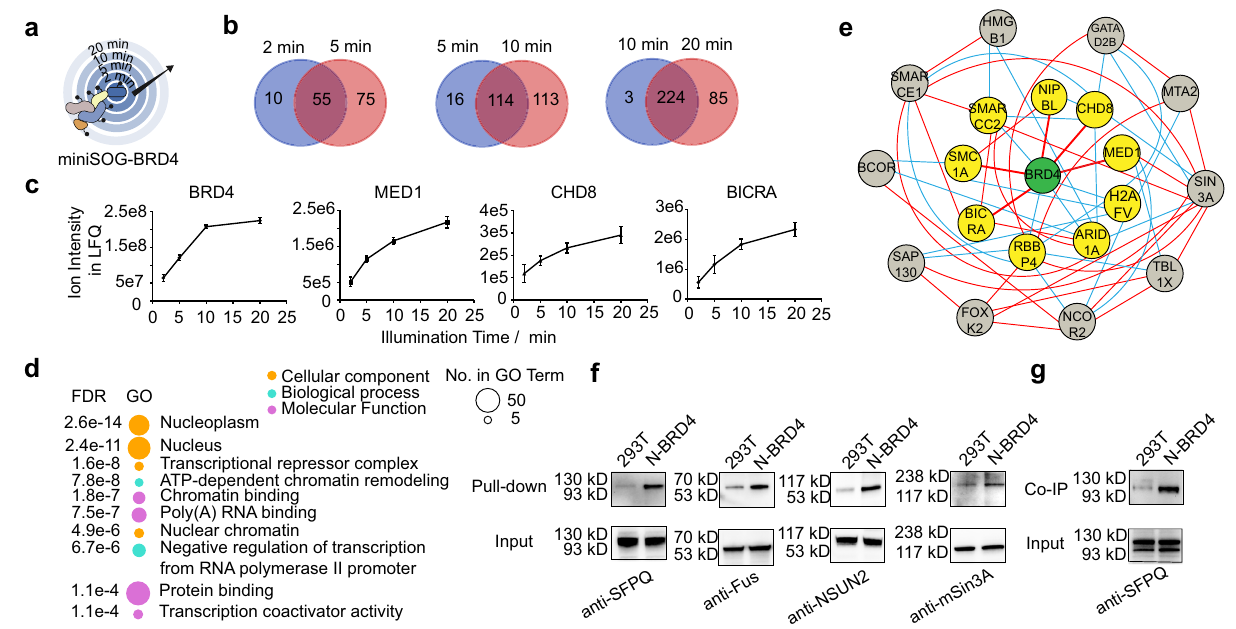
Fig. 4 | Spatiotemporally-resolved pro fi ling of BRD4 binding proteins with different labeling radii triggered by illumination duration. a Schematic of miniSOG-mediated BRD4 proximity labeling with irradiation time: 2, 5, 10, and 20min. b Overlapping of the identi fi ed proteins for different illumination time points. The enrichment of the identi fi ed proteins is statistically signi fi cant in HEK293T-miniSOG-BRD4compared with wild-typeHEK293T. c The ion intensityin label-free quanti fi cation for representative known BRD4 binding proteins across the indicated irradiation times. n =3 biologically independent samples. Data are presentedasmeanvalues±SD. d Geneontology(GO)analysisofproteinsidenti fi ed in2mingroup.ThetoptenGOtermsarelisted.Bubblesarecoloredaccordingtoto